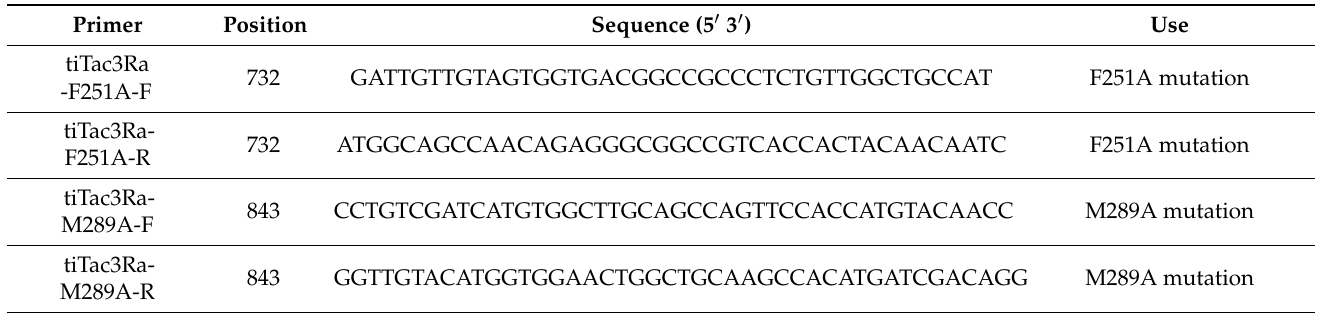
Table 1. Primers for modification of tiTac3Ra mutant expression